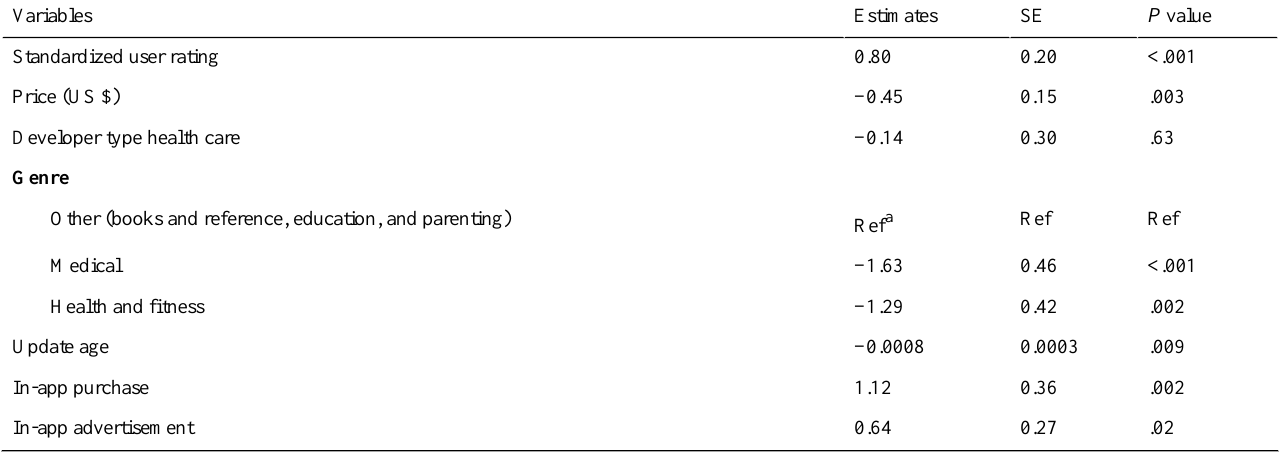
Table 4. Ordinal logistic regression for factors associated with user downloads (n=213).